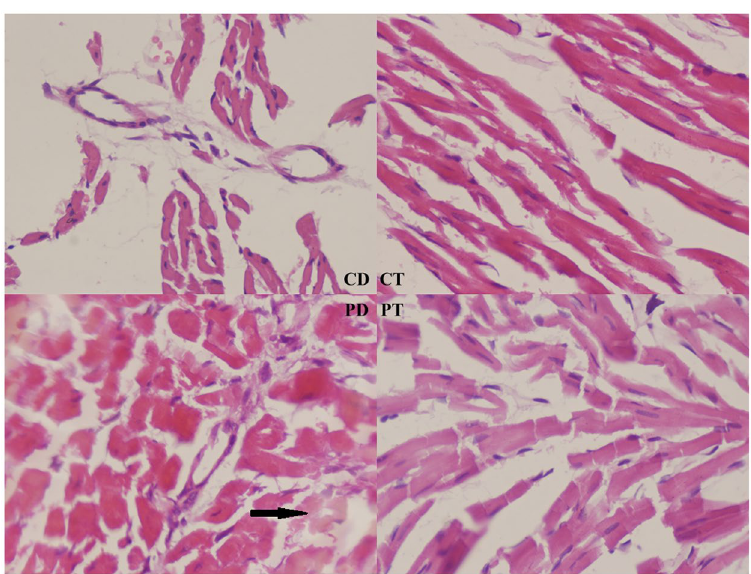
Figure 2. HE staining of rat right ventricular myocardiocytes. CD group rats were treated with normal saline (NS) for 28 days followed by DMSO for 7 days. CT group rats were treated with NS for 28 days followed by T0901317 for 7 days. PD group rats were treated with MCT for 28 days followed by DMSO for 7 days. PT group rats were treated with MCT for 28 days followed by T0901317 for 7 days. The arrow in the PD group indicates myocardiocyte lysis and remodeling (400X). (CD: rats treated with NS + DMSO, CT: rats treated with NS + T0901317, PD: rats treated with MCT + DMSO, PT, rats treated with MCT +